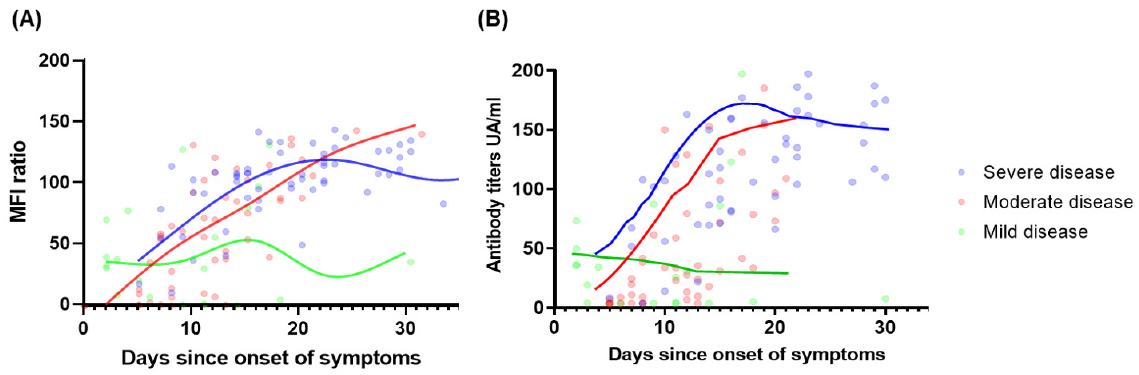
Figure 2. Trends in antibody evolution stratified by disease severity. Smooth fit curves for antibody kinetics tested with ( A ) Luminex and ( B )